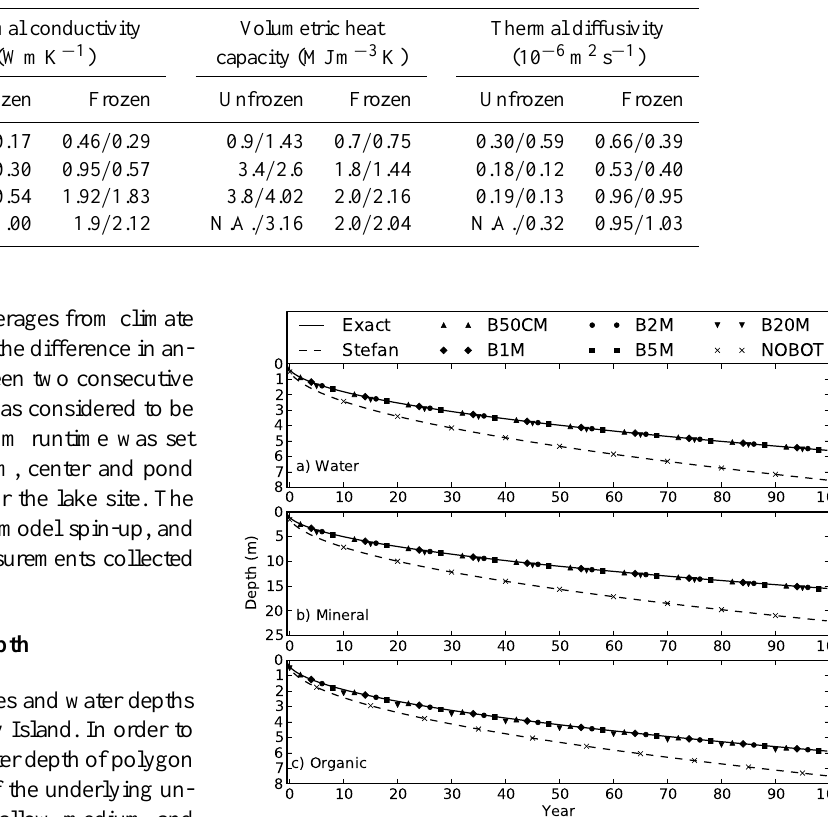
Table 3. Thermal properties of different types of soil on Samoylov Island. The first is derived using soil temperature measurements; the second is calculated using the default scheme in the DOS-TEM.